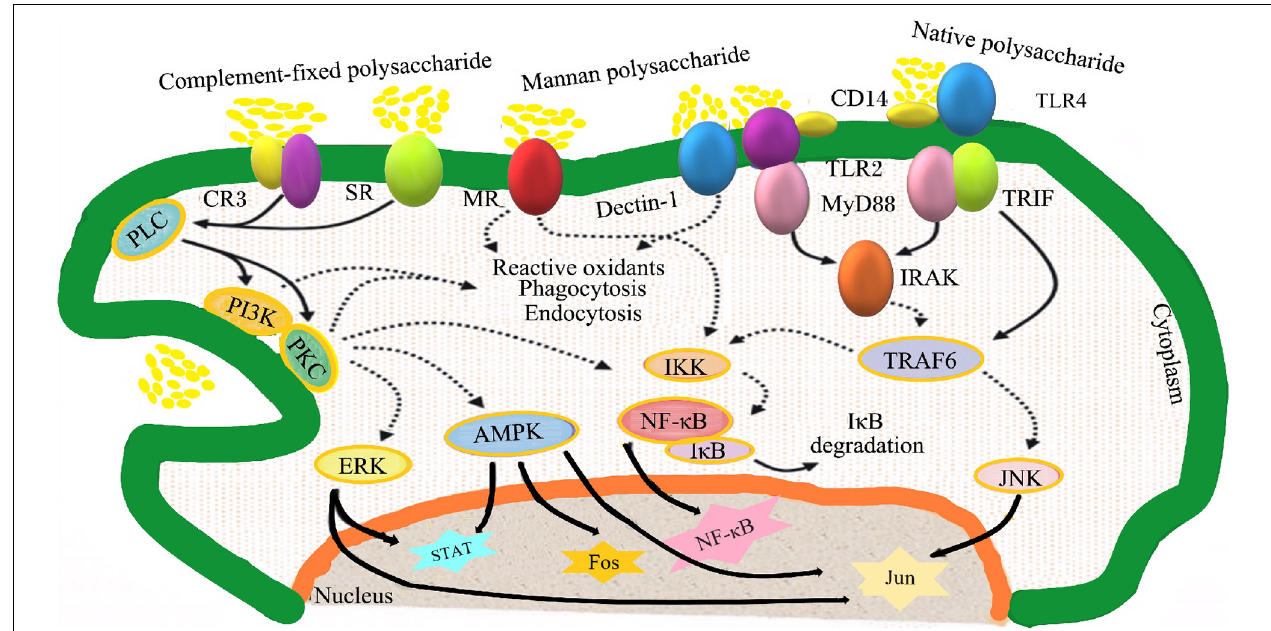
FIGURE 3 | Signaling pathways involved in macrophage activation by polysaccharides. CR3, complement receptor 3; SR, scavenger receptors; MR, mannose receptors; Dectin- 1, dendritic cell-associated C-type lectin-1; CD14, cluster of differentiation antigen 14; TLR2, Toll-like receptor 2; TLR4, Toll-like receptor 4; PLC, phospholipases C; TRIF, Toll/IL-1 domain containing adaptor inducing interferon β ; MyD88, myeloid differentiation factor 88; PI3K, phosphatidylinositol 3 kinase; PKC, protein kinase C; IRAK, interleukin-1 receptor associated kinase; IKK, inhibitor of nuclear factor kappa-B kinase; TRAF6, tumor necrosis factor receptor-associated factor 6; NF- κ B, nuclear factor kappa-B; I κ B, inhibitor of nuclear factor kappa-B; MAPK, mitogen-activated protein kinase; ERK, extracellular signal-regulated kinase; STAT, signal trans- ducers and activators of transcription; JNK, c-Jun N-terminal